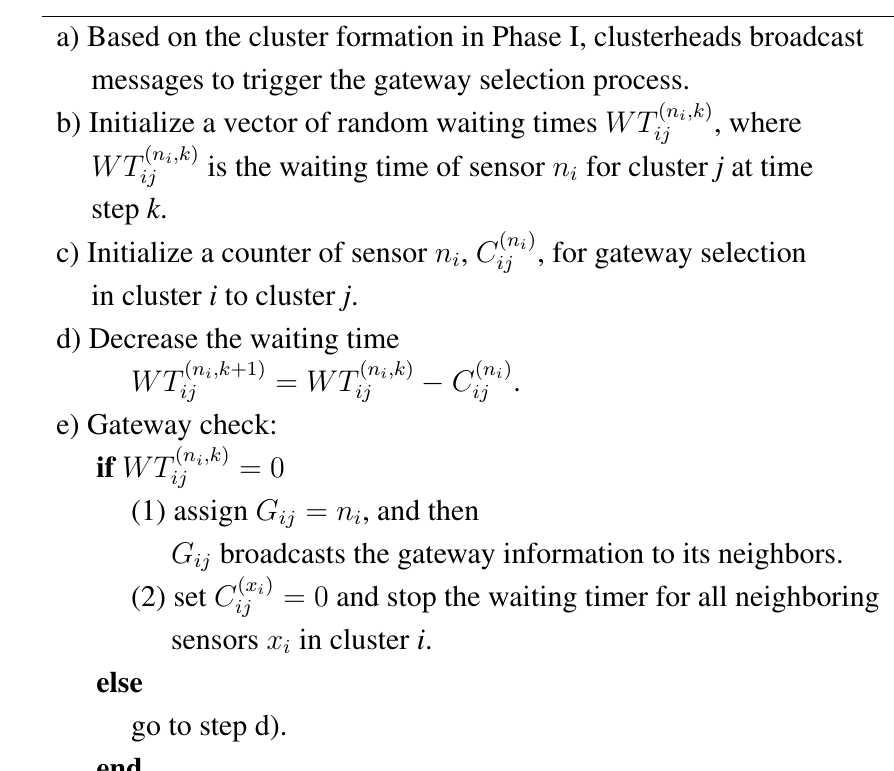
Table 3. Description of Gateway